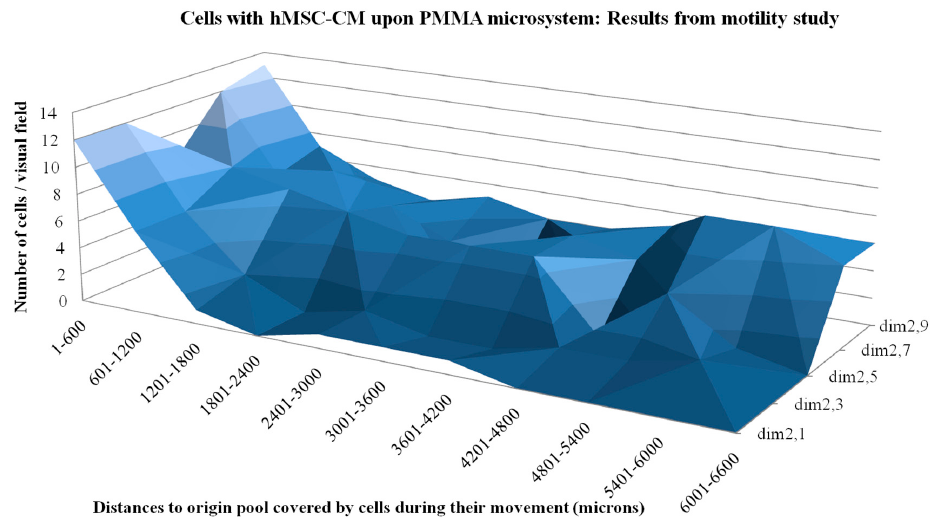
Figure 7. Results from the motility study of cells cultured on the fractal microsystem pre-incubated with hMSC-CM medium: Cell distance to origin well distribution along the different channels.